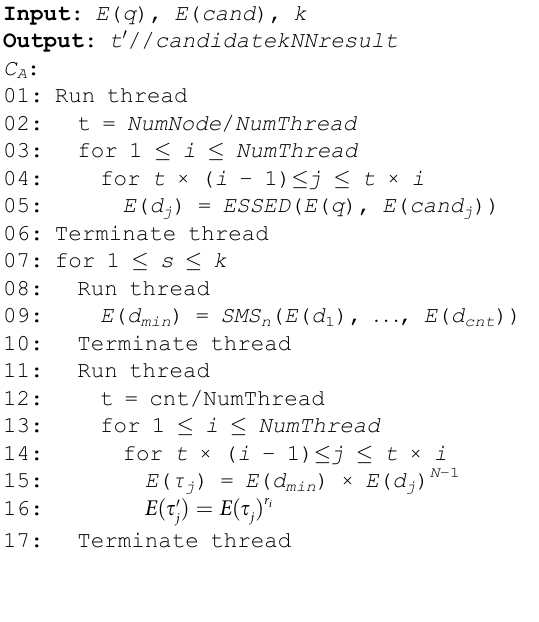
Algorithm 4 k-nearest neighbor search